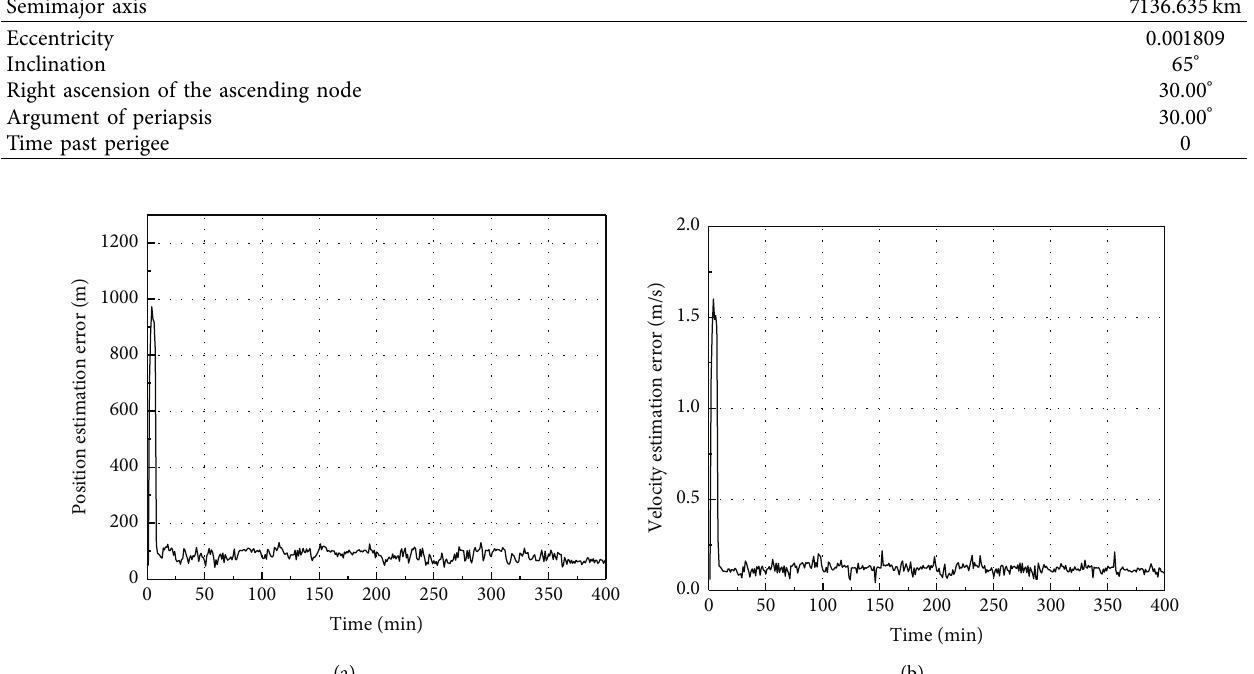
Table 1: Number of satellite initial orbits.